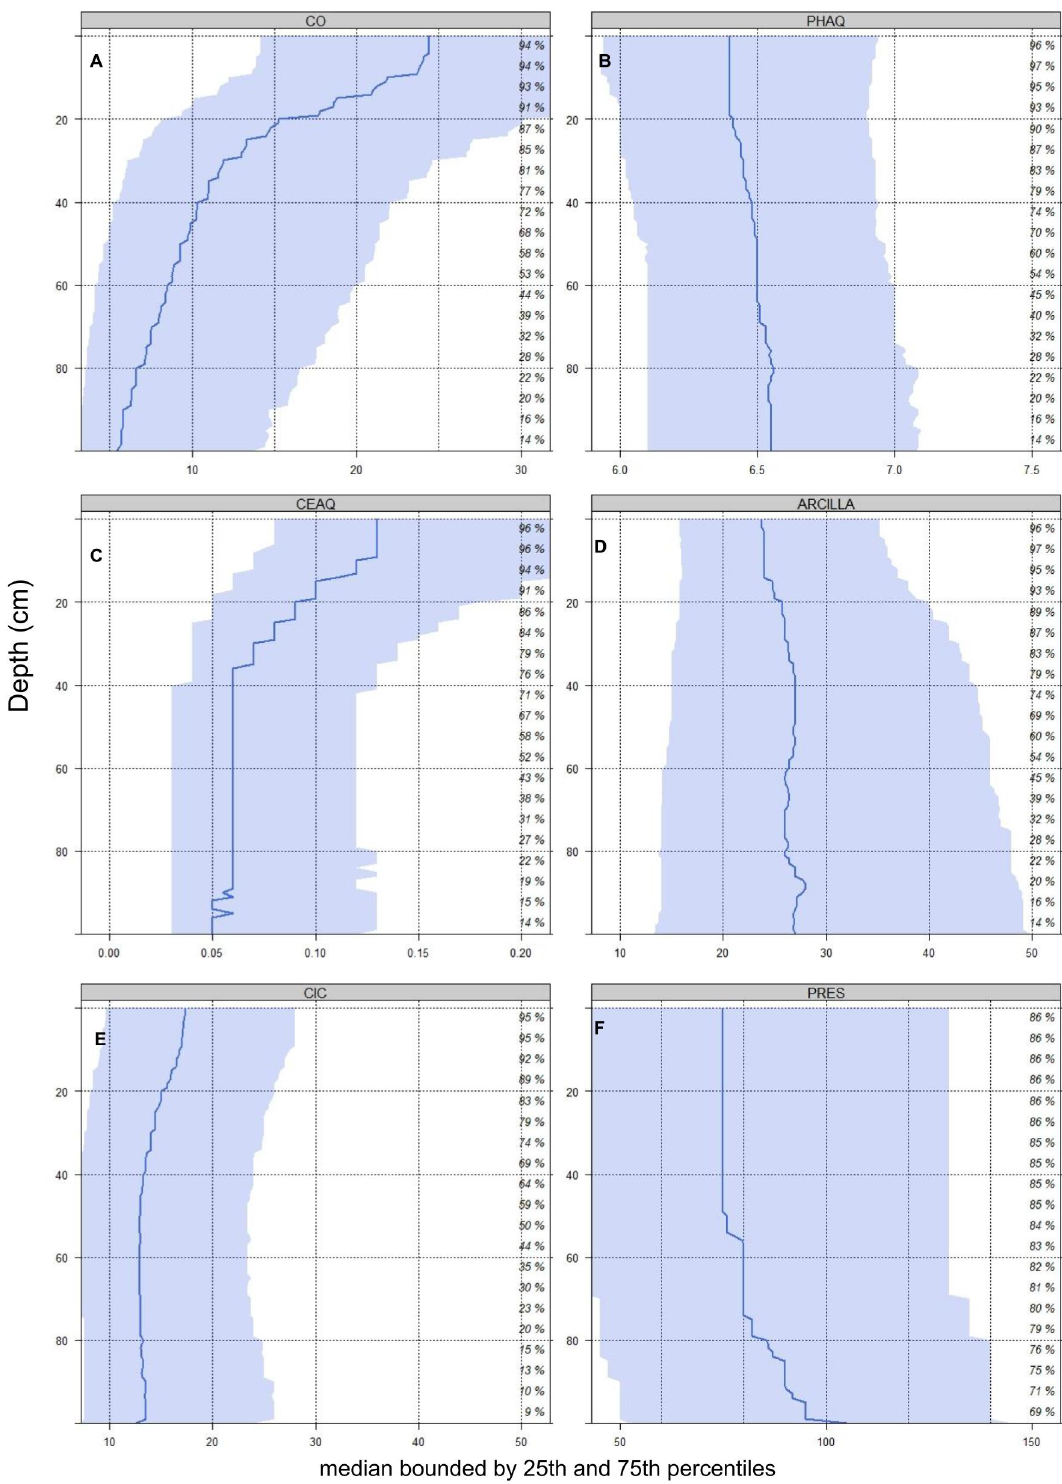
Figure 3. Variation in the concentration of soil variables with respect to depth (cm): (a) profile average of organic carbon (CO); (b) profile average of pH H 2 O; (c) profile average of electric conductivity in water (CEAQ); (d) profile average of electric conductivity in water total clay (ARCILLA); (e) profile average of the cation exchange capacity (CIC); and (f) profile average of the effective depth (PRES). The blue area represents the range of variation in the properties.